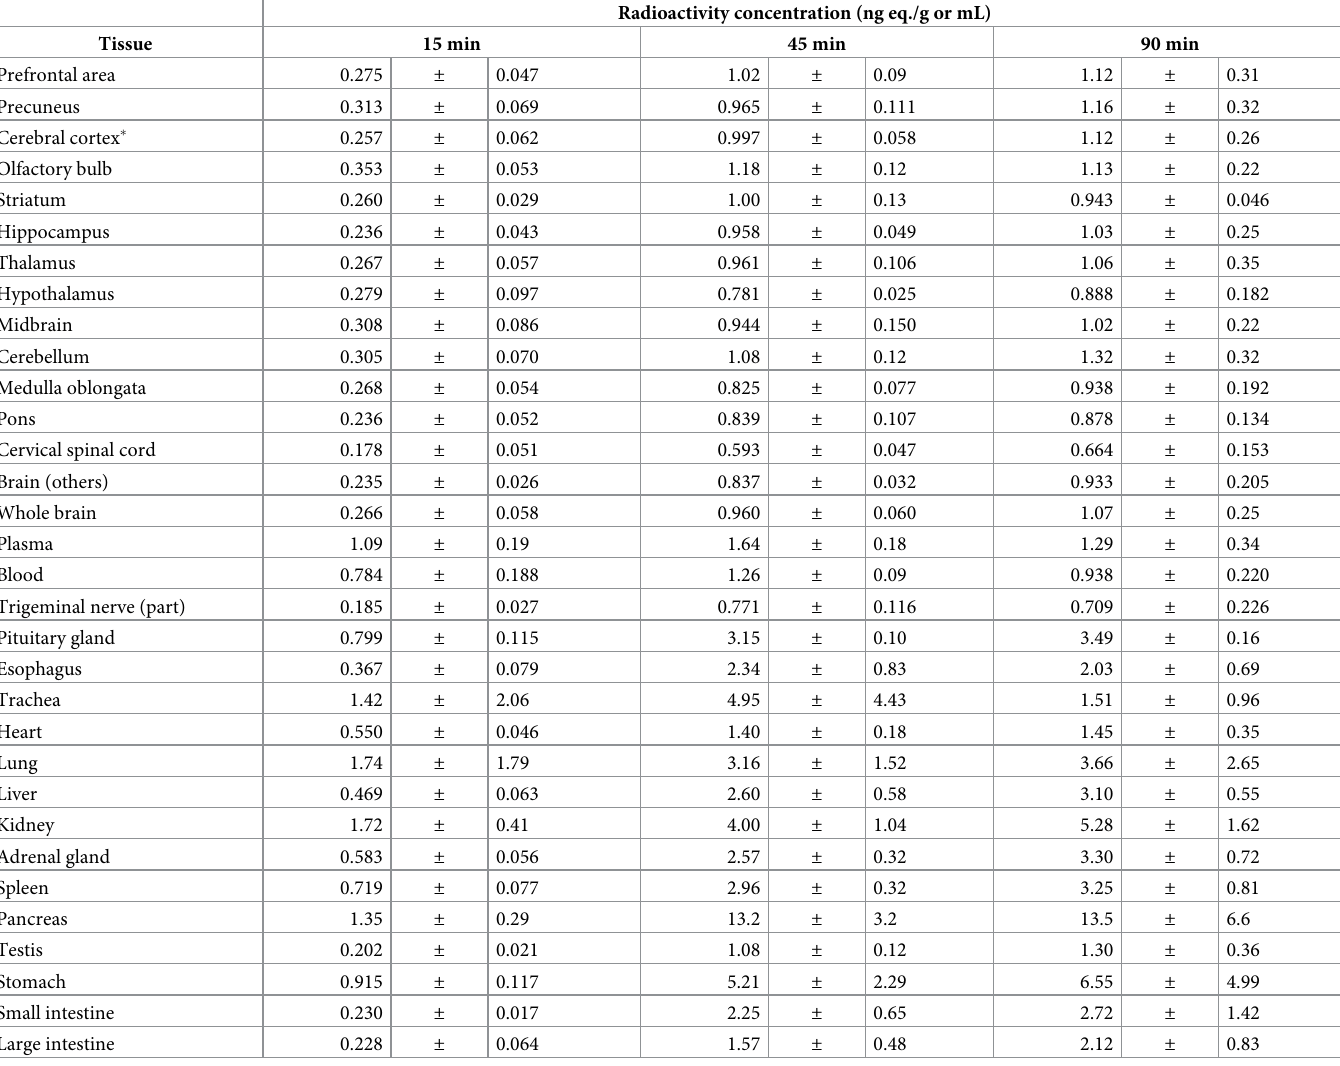
Table 1. Radioactivity concentrations in tissues after single intranasal administration of [ 3 H]TTA-121 to male rabbits (dose: 4 U/body). Radioactivity concentration (ng eq./g or